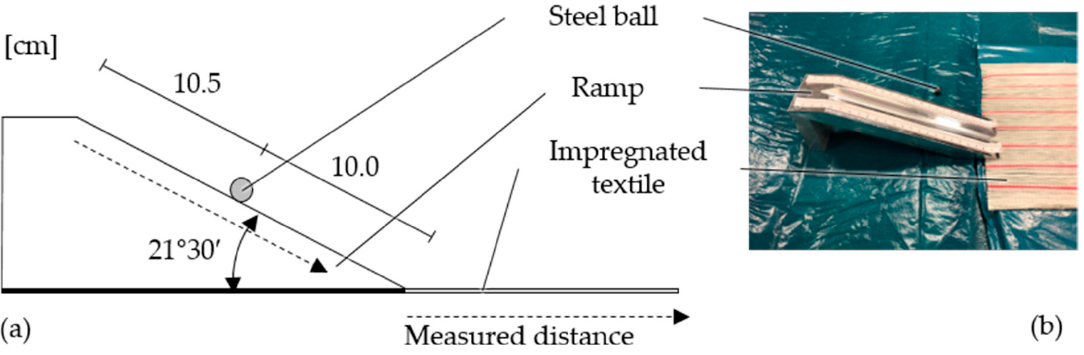
Figure 3. Representation of the rolling ball test used in this work: ( a ) schematic representation; ( b ) picture.